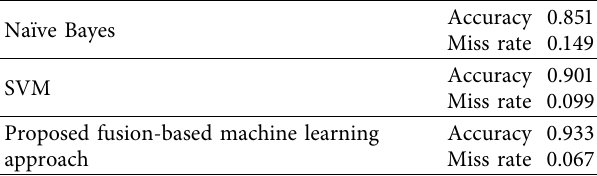
Table 8: Comparison of performance of the proposed system using